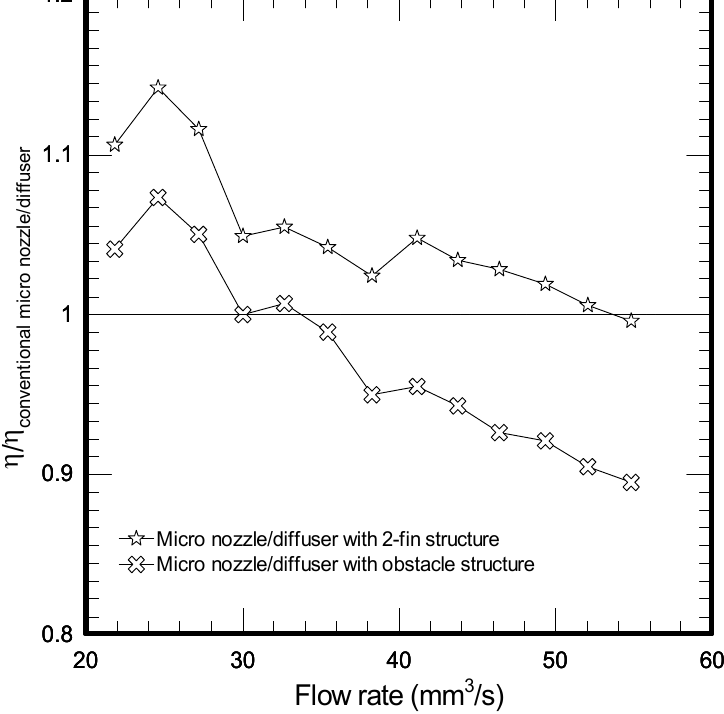
Figure 4. Flow rate vs . the efficiency ratio between conventional micro